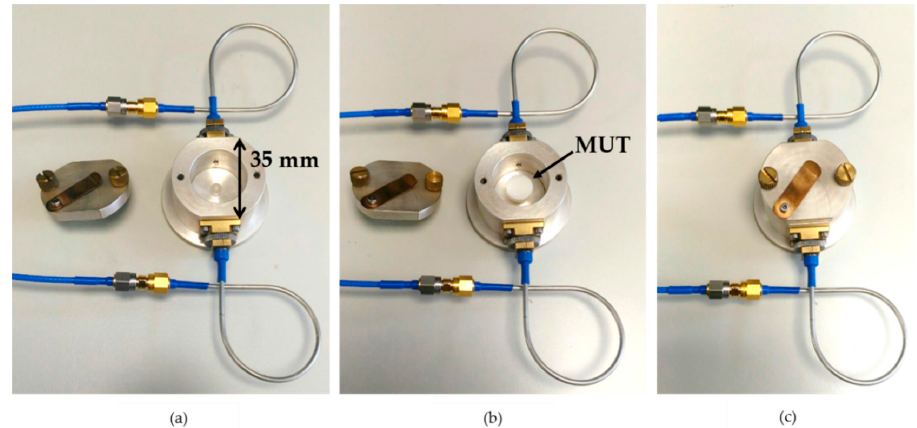
Figure 7. ( a ) Top view of the TE 01 δ mode cavity resonator; ( b ) MUT placed at the center in the metal cavity; ( c ) TE 01 δ mode cavity resonator closed with MUT inside.